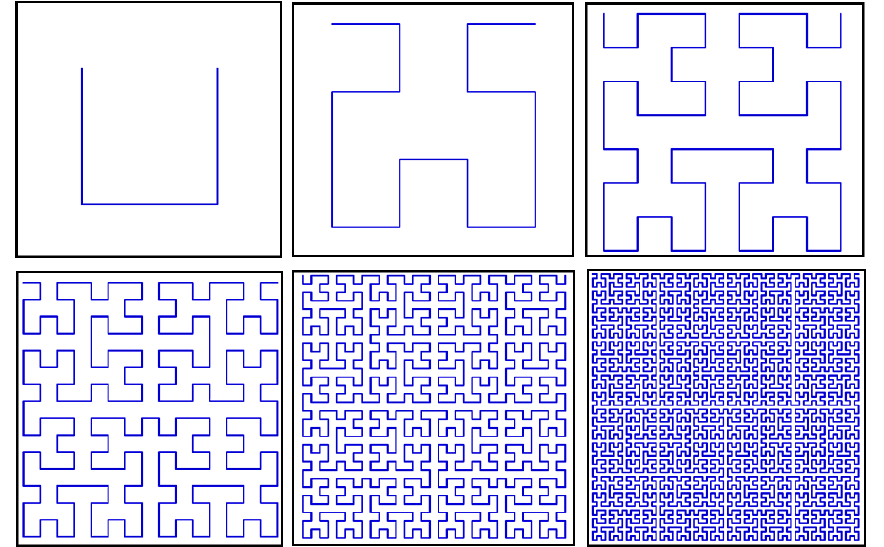
Figure 1. Space-filling curve explored by Hilbert (First six steps/orders shown).